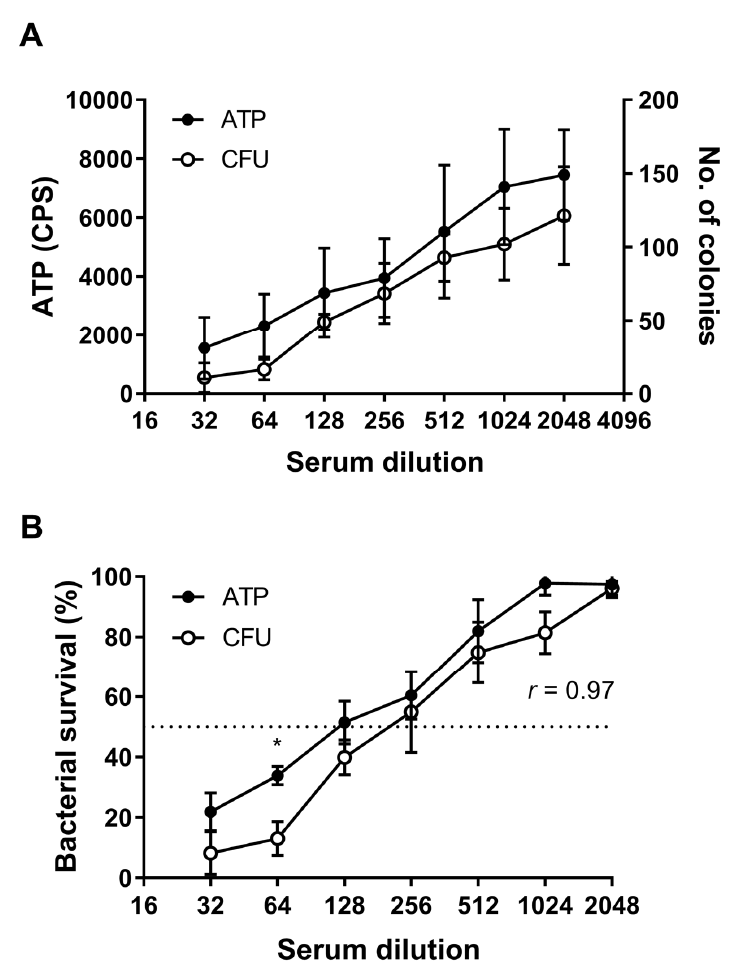
Figure 4. Comparison of SBA data obtained using CFU or ATP methods to quantify bacteria. Raw ATP (luminescence) values and colony counts obtained in an assay for SBA ( A ) and a comparison of SBA titres using CFU and ATP methods ( B ). Serial twofold dilutions of murine serum raised to OMV extracts from N. gonorrhoeae P9-17 were incubated with live N. gonorrohoeae P9-17. Data are combined means ± SD from three independent experiments. ATP values were scaled to the left axis and CFU values to the right axis in ( A ). The correlation between CFU and ATP values was calculated using a two-tailed Pearson coefficient. Differences between matched sets of CFU or ATP values were determined using multiple t -tests. * p < 0.05.